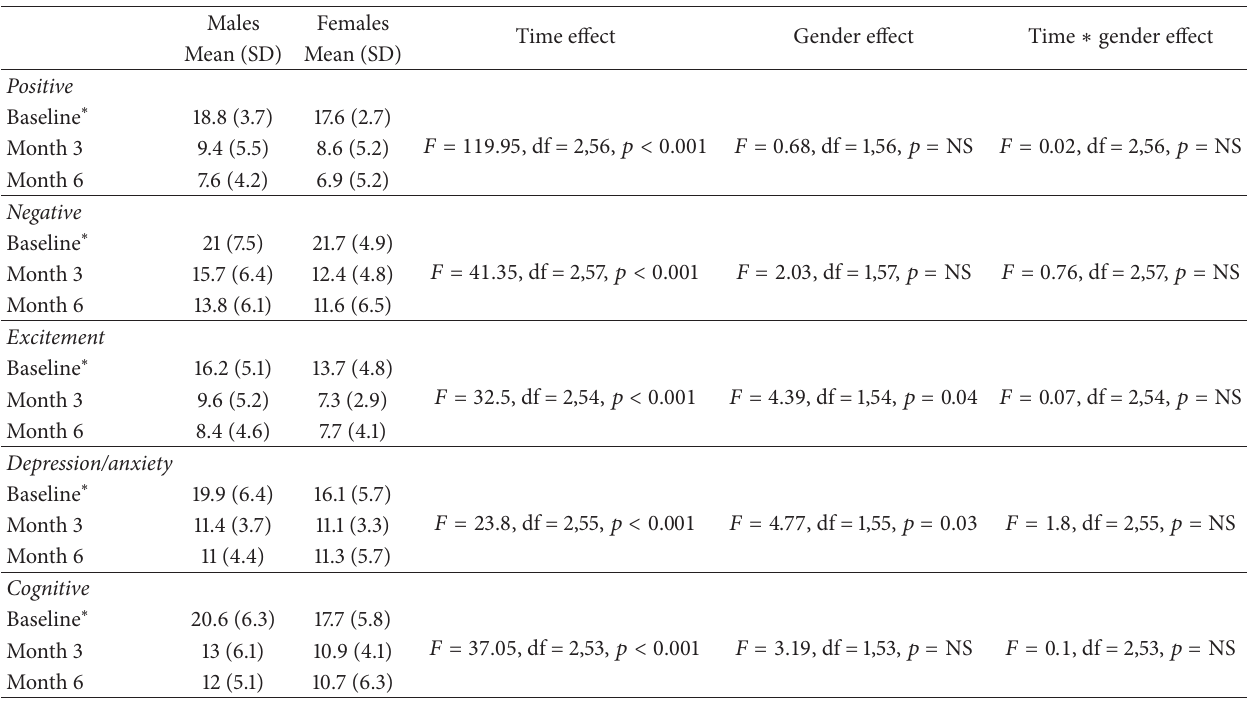
Table 2: Repeated measures ANOVA for PANSS